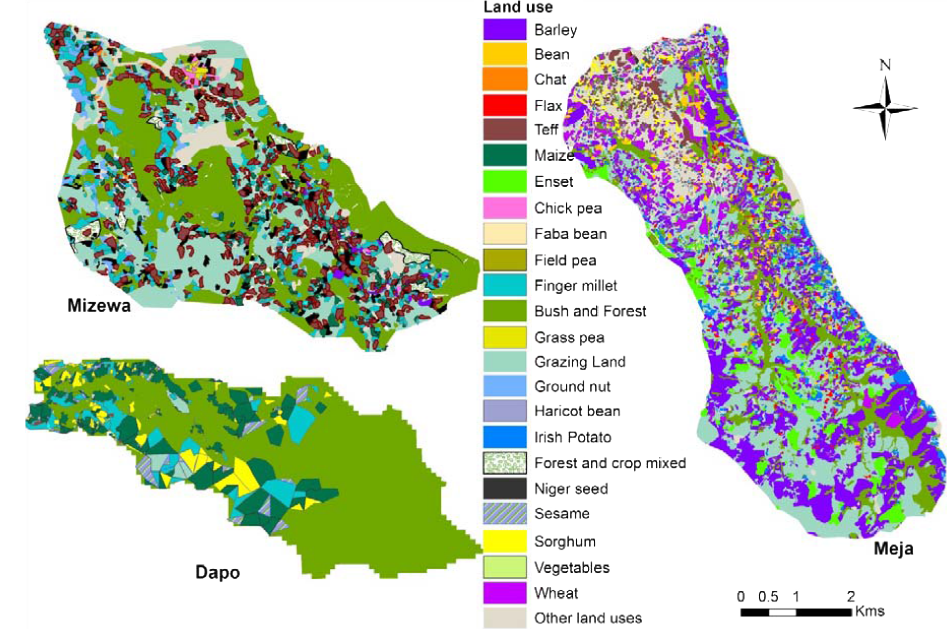
Figure 4. Crop pattern maps of the study watersheds during the study period (2011). Table 3. Response equations of selected crops to N and P application rates (kgha − 1 ) where Y stands for crop yield (kgha − 1